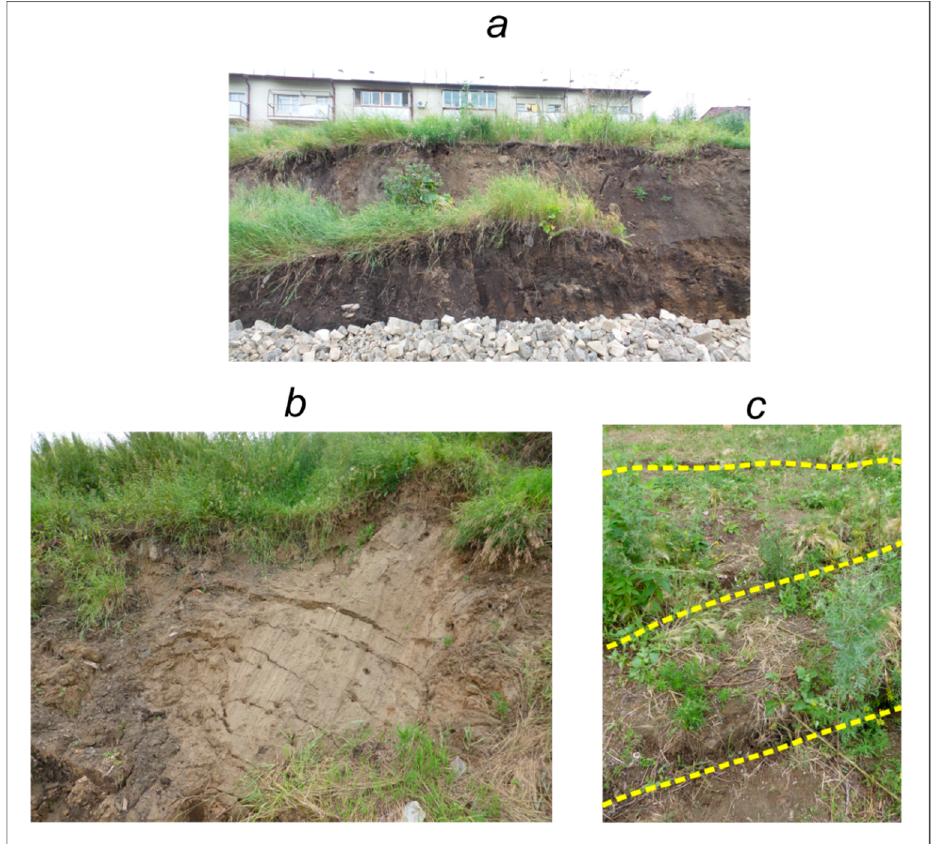
Figure 7. Landslide deformations of the bank line of the second terrace of the IyaRiver (the town of Tulun): ( a )—frontal part of landslide deformations; ( b )—landslide block main scarp; ( c )—extension fracture on the surface of the second terrace.